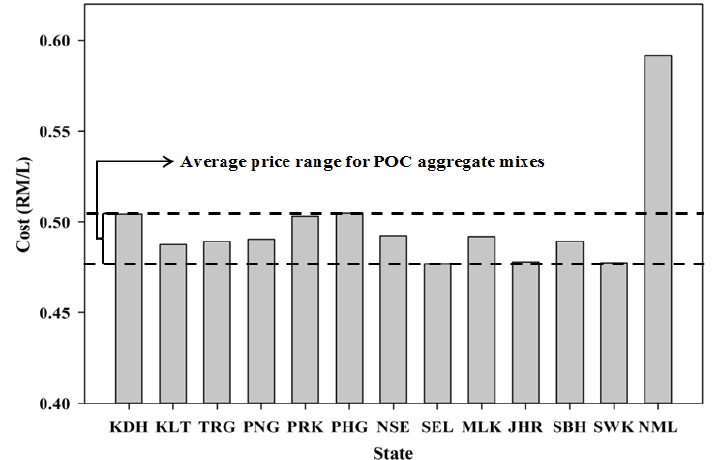
Figure 18. Cost of mortar incorporating POC aggregate (Kanadasan and Abdul Razak